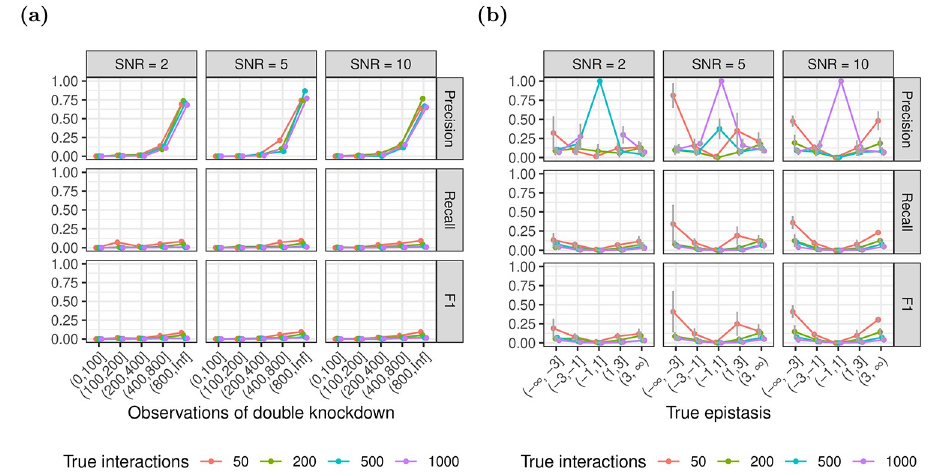
Fig 8. Simulations repeated using xyz and larger data sets. (a) number of observations of double knockdown. (b) Precision/recall/f1 by actual effect strength.